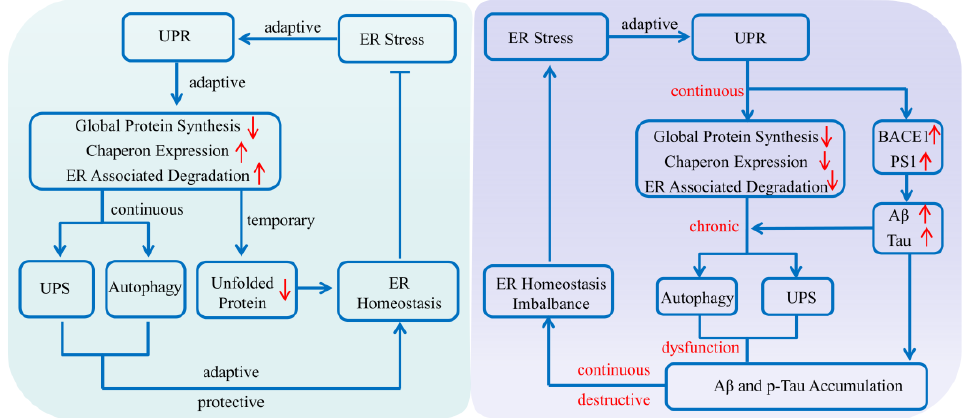
Figure 1. Protein quality control system affecting Alzheimer ’ s disease. The endoplasmic reticulum system, autophagy – lysosome system and ubiquitin – proteasome system are the three main regula- tory pathways in maintaining normal cell metabolism and avoiding protein dysfunction. Once ab- normal protein accumulates in the brain, the unfolded protein response is initially provoked to pro- duce normal proteins by upregulating the expression of molecular chaperones, while reducing the accumulation of misfolded proteins via inhibiting the synthesis of total proteins. If the endoplasmic reticulum system fails to refold the abnormal protein for some reason, the molecular chaperones will deliver the abnormal proteins to the autophagy – lysosome system or the ubiquitin – proteasome system, where the abnormal proteins can be effectively degraded. While during AD progression, all the abnormal expression and impaired function of key components of these pathways, as well as defects in the proteins ’ interplay, could induce dysregulation of proteostasis and contribute to AD pathogenesis. (Aβ: amyloid - β protein; BACE1: β -amyloid precursor protein cleaving enzyme 1; ER: endoplasmic reticulum; PS1: presenilin 1; p-Tau: hyperphosphorylated Tau; UPR: unfolded protein response; UPS: ubiquitin – proteasome system). The upward red arrow indicates up-regulation of expression, while the downward red arrow indicates downregulation of expression. The blue arrow indicates the activation of process, while the blue T arrow indicates the inhibition of process.